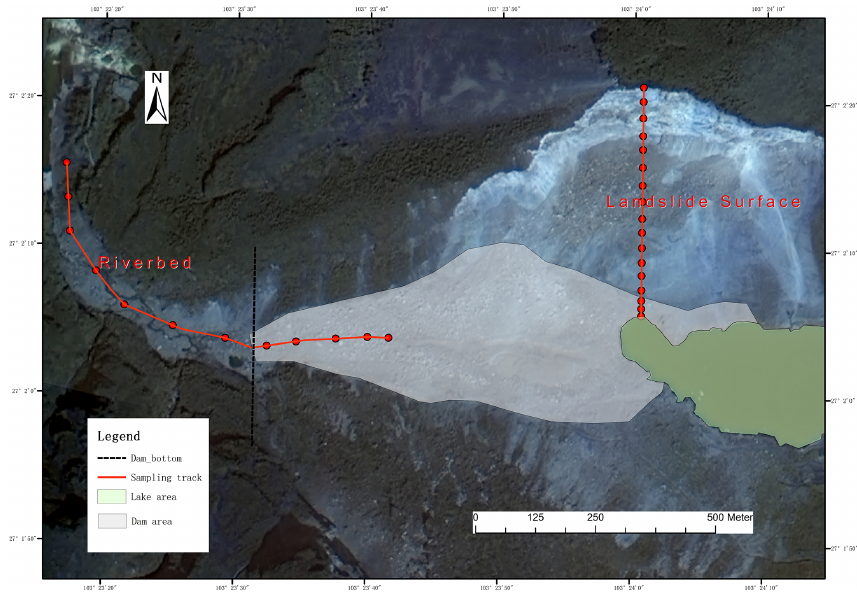
Figure 11. Hongshiyan landslide dam (image from the Gaofen-1 satellite).